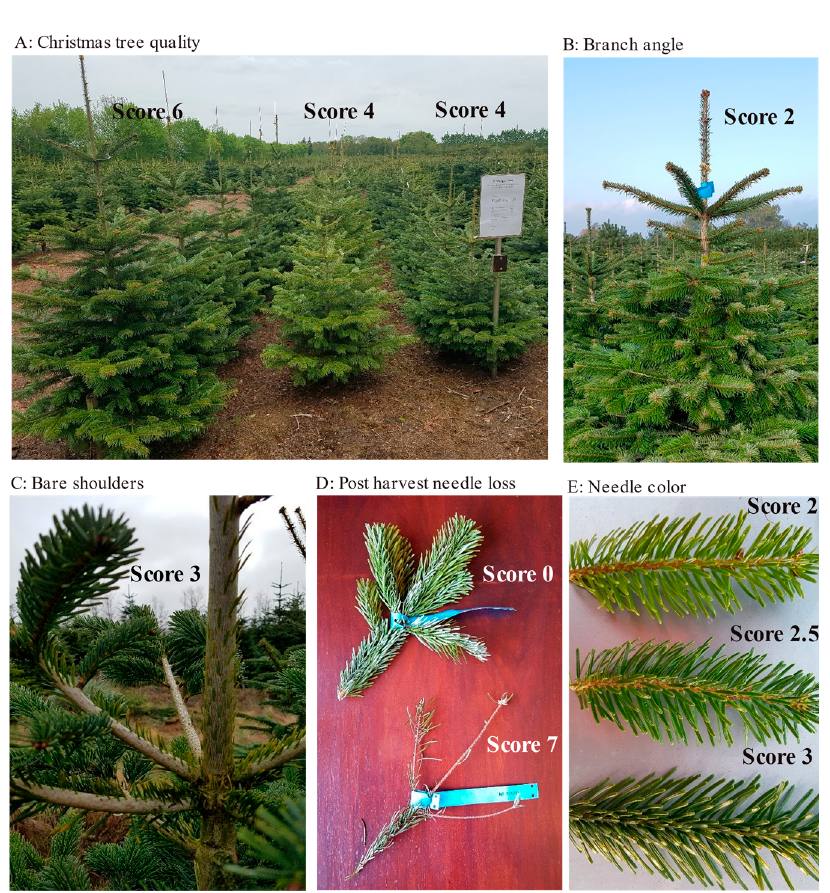
Figure 3. Photos describing the traits: ( A ) Christmas tree quality; ( B ) branch angle; ( C ) needle disorder: bare shoulders; ( D ) post-harvest quality; ( E ) needle color.